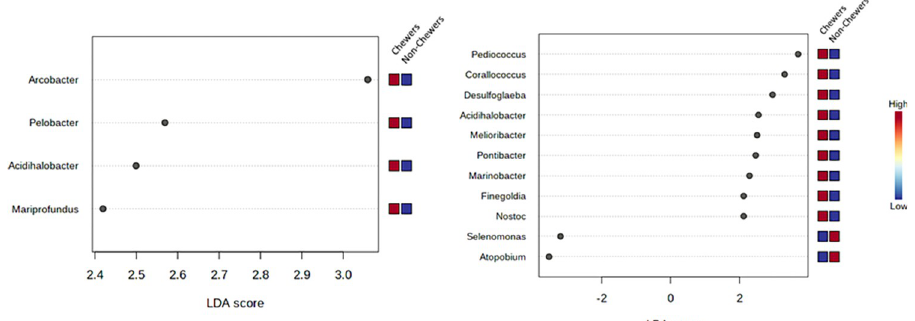
Fig 7. a. Lefse Plots: Genus-level oral microbiome significant features composition of Betel quid chewers Vs. Non- Chewers; b. (21–30 years old young individuals) Betel quid chewers Vs.